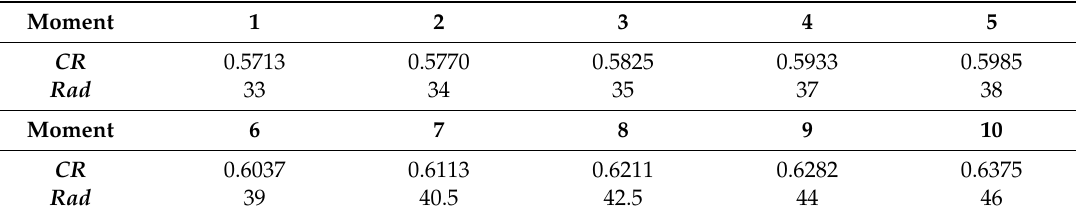
Table 2. The results calculated by the original model in a head-on encountering scenario. CR: collision risk without considering ship manoeuvrability, Rad: danger sector without considering ship